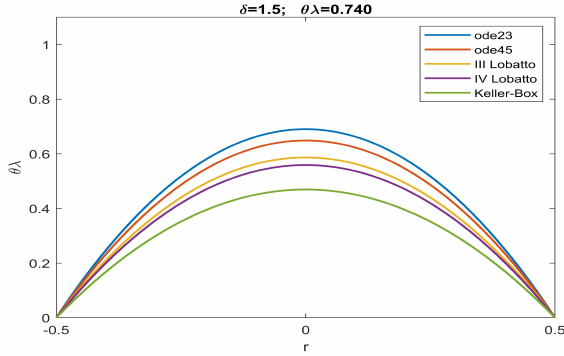
Figure 5. Recovering of u ( r ) for δ = 1 and θλ = 0.791.